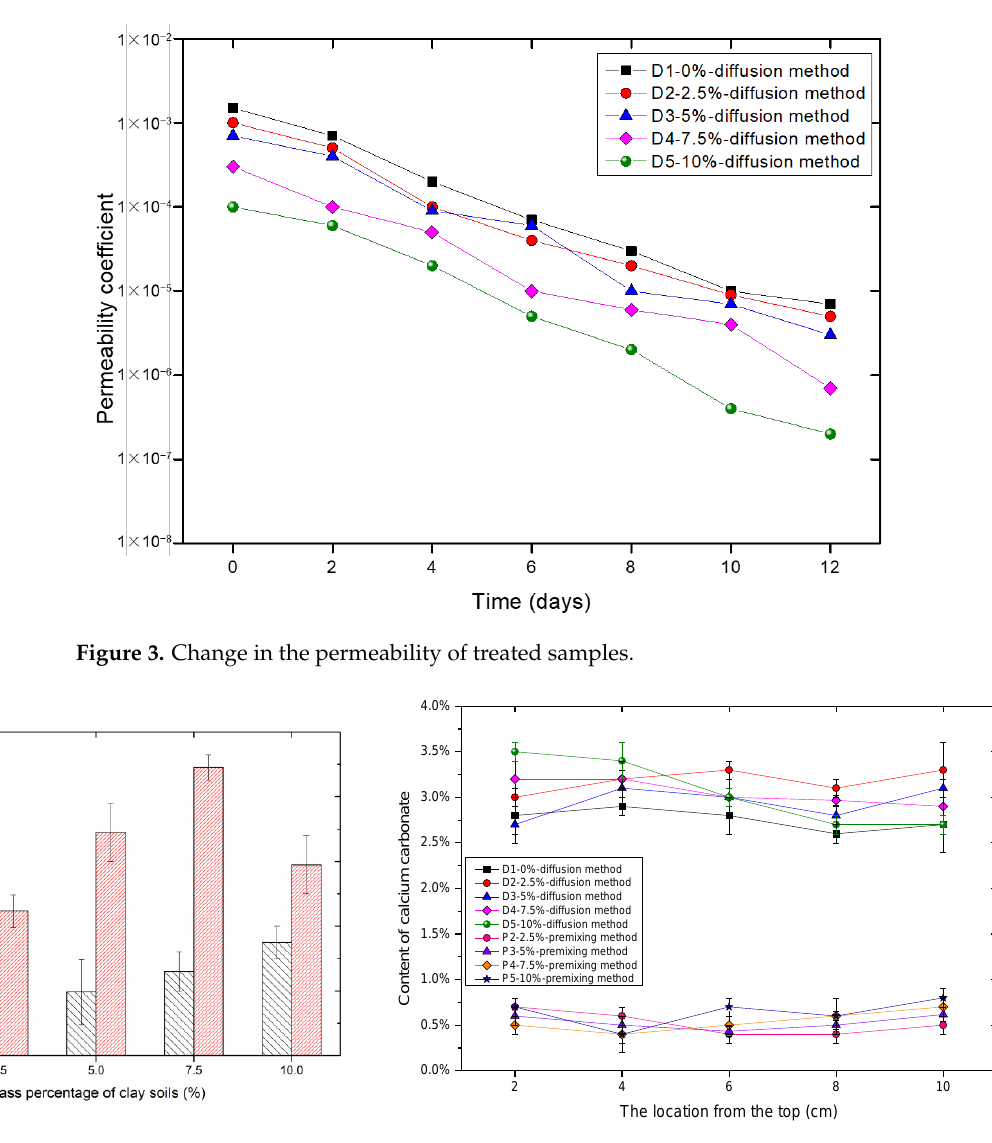
Figure 3. Change in the permeability of treated samples.